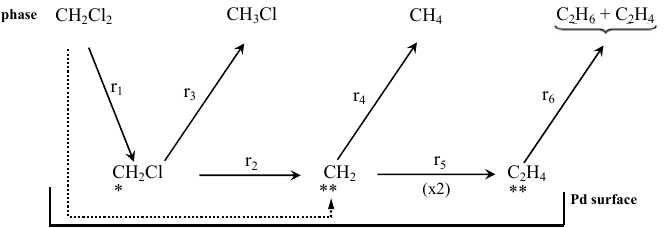
Scheme 2. Reaction scheme for the HDC of DCM proposed in ref. [38] (solid arrows) and